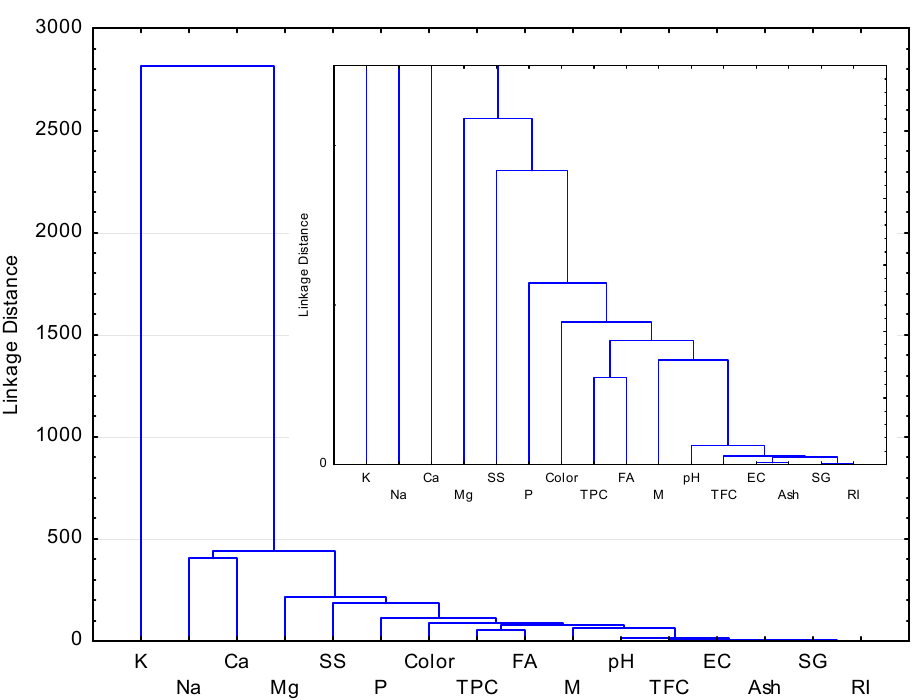
Figure 5. Graphical representation of PC for the analyzed honey samples: ( a ) scores for PC2 vs. PC1 and ( b ) scores for PC3 vs. PC1.